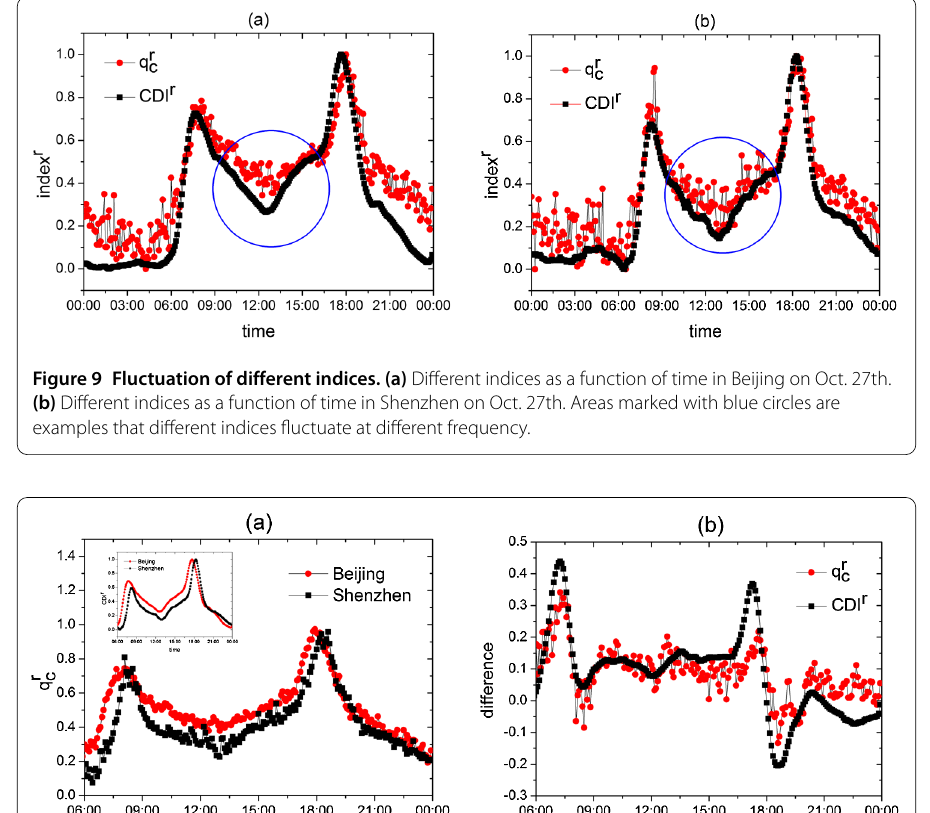
We also find that the two indices show different sensibility to the change of road con- dition. Areas in Figure  marked with blue circle show one example of this